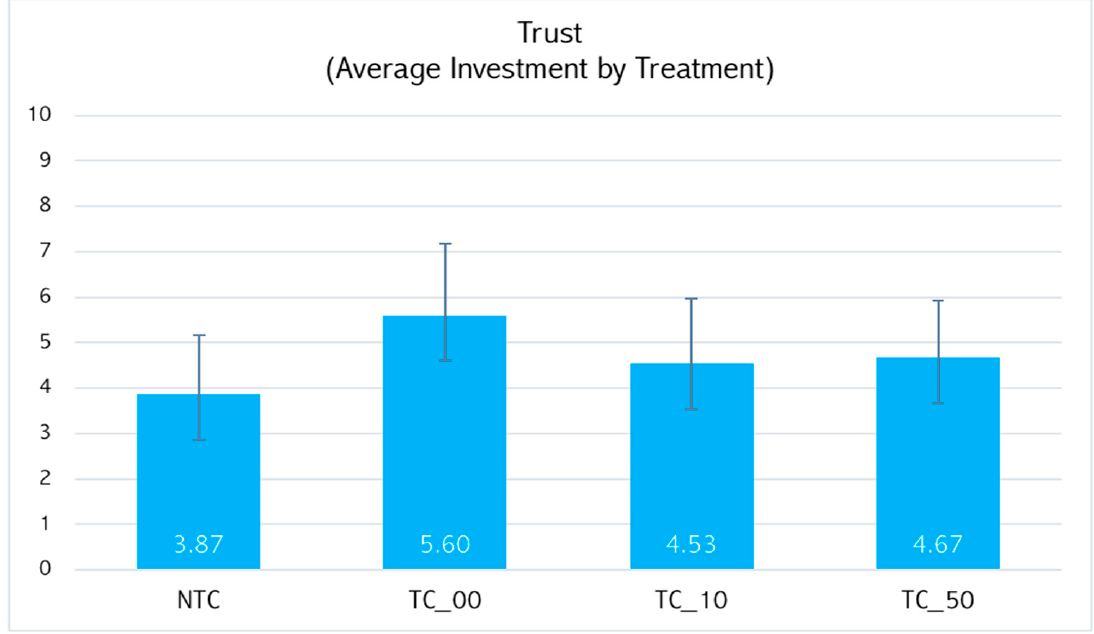
Figure 3. Mean amount sent by the trustor, by treatment.